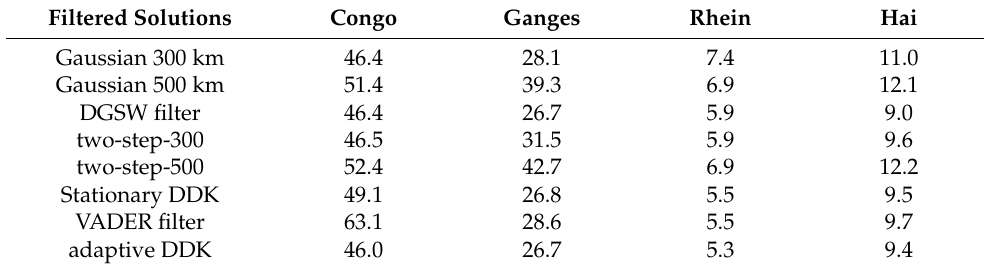
Figure 7. Local total mass anomaly time series of different filtered solutions. The unit is gigatons (Gt). The CSR RL06 v2.0 mascon solutions are included for comparison. Table 3. RMSD of local total mass anomalies of different filtered solutions (Gt). The CSR RL06 v2.0 mascon solutions are treated as referenced truth.